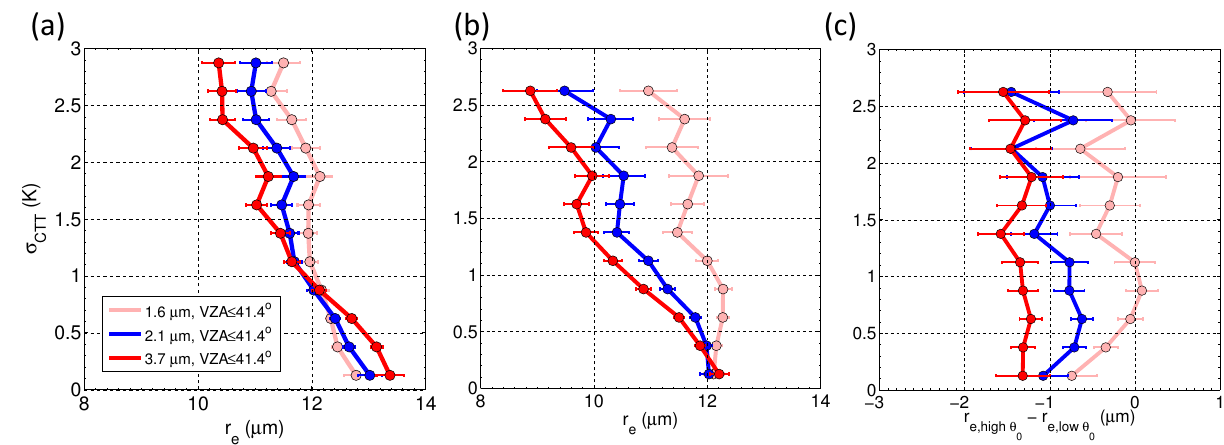
Figure 15. As for Fig. 11 except for effective radius for low θ 0 (a) , high θ 0 (b) , and the difference between r e at high and low θ 0 (c) .